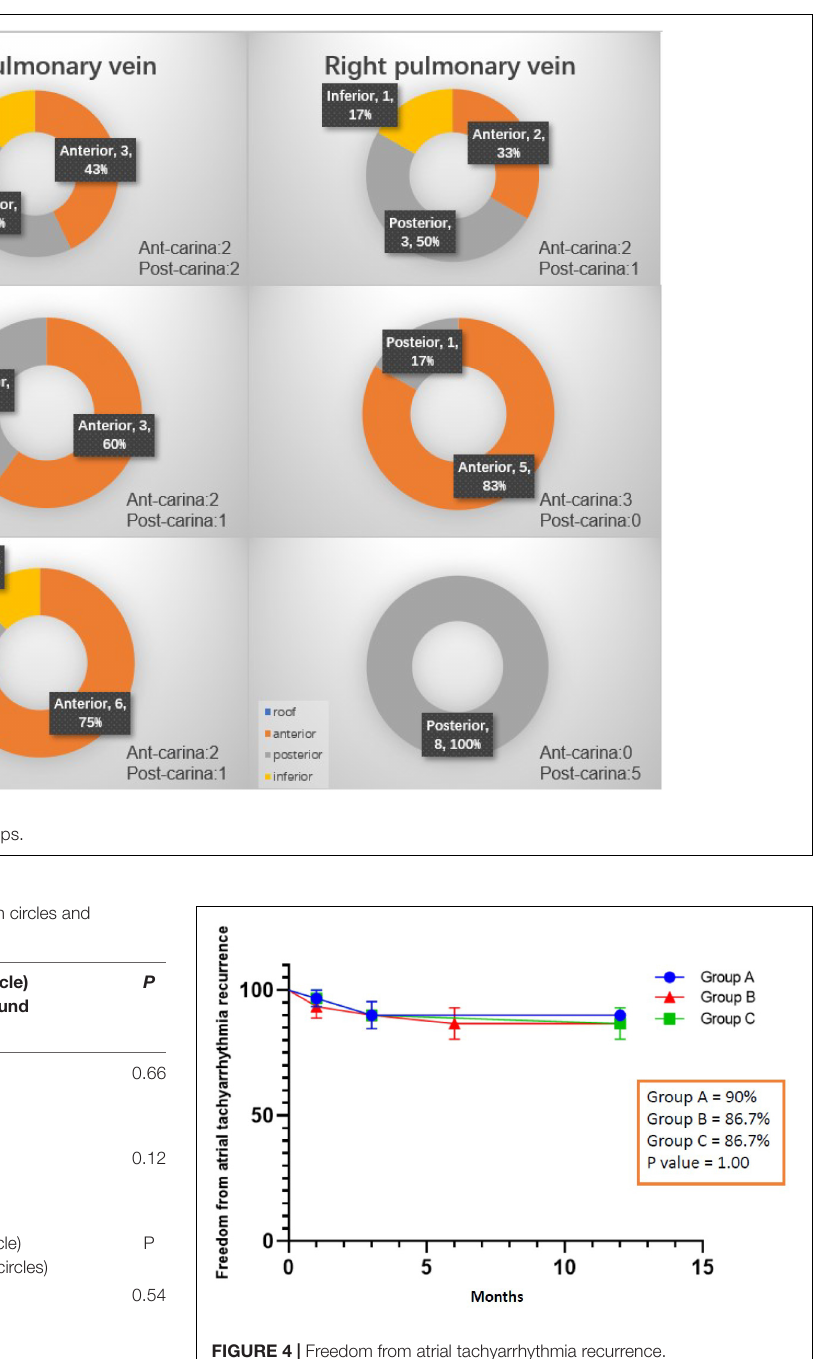
FIGURE 4 | Freedom from atrial tachyarrhythmia